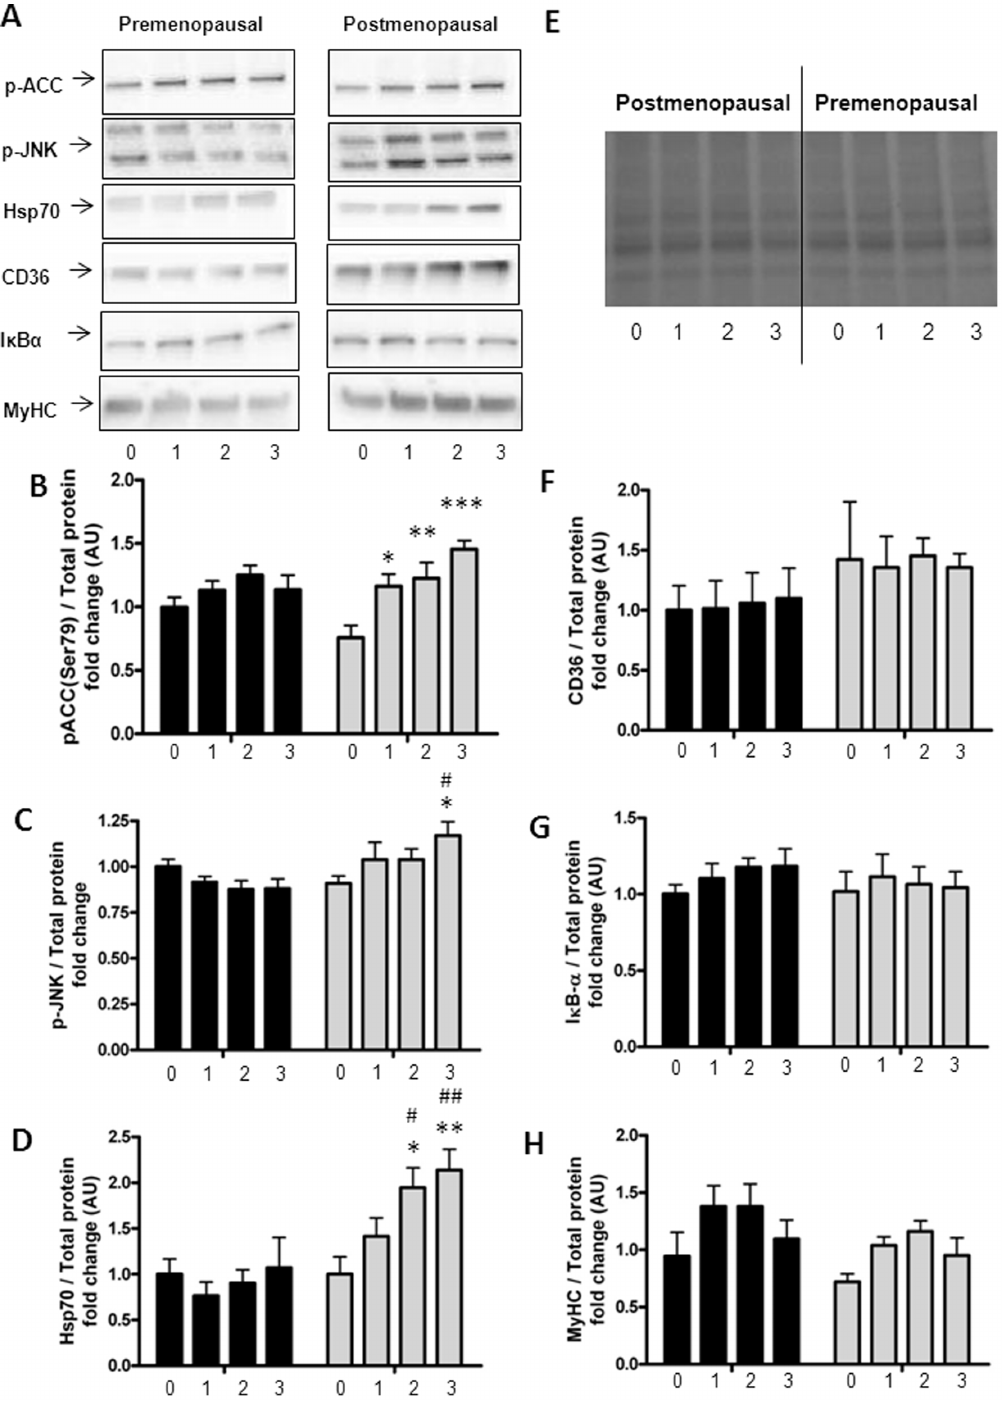
Figure 2. Protein expression in palmitate treated myotubes from premenopausal and postmenopausal women. Satellite cells were isolated from vastus lateralis biopsies from premenopausal and postmenopausal women. Cells were grown in culture until mature myotubes were formed. Myotubes were treated with palmitate in the last one, two or three days of differentiation. Protein lysates from the myotubes were immunoblottet to assess the protein expression of specific proteins as stated below. Protein expression in pre-myotubes (n=6, black bars) and post- myotubes (n=5, white bars) in response to palmitate treatment, (A) Representative immunoblots of all investigated proteins, (B) p-ACC-Ser79 (280 kDa) was increased only in post-myotubes in response to palmitate treatment, (C) p-JNK-Thr183/Tyr185 (54/46 kDa) was increased after three days of palmitate treatment in post-myotubes and reached significantly higher levels than in post-myotubes, (D) Hsp70 (72 kDa) was increased after two and three days of palmitate treatment in post-myotubes, and reached significantly higher levels than in pre-myotubes, (E) Representative blot of total protein, (F) CD36 (88 kDa) was unaffected by both palmitate treatment and menopausal status, (G) I k B a (39 kDa) was unaffected by both palmitate treatment and menopausal status, (H) MyHC (230 kDa) was unaffected by both palmitate treatment and menopausal status. Significantly different from control; * p , 0.05, ** p , 0.01, *** p , 0.001. Significantly different from premenopausal, at same palmitate exposure time; # p , 0.05,